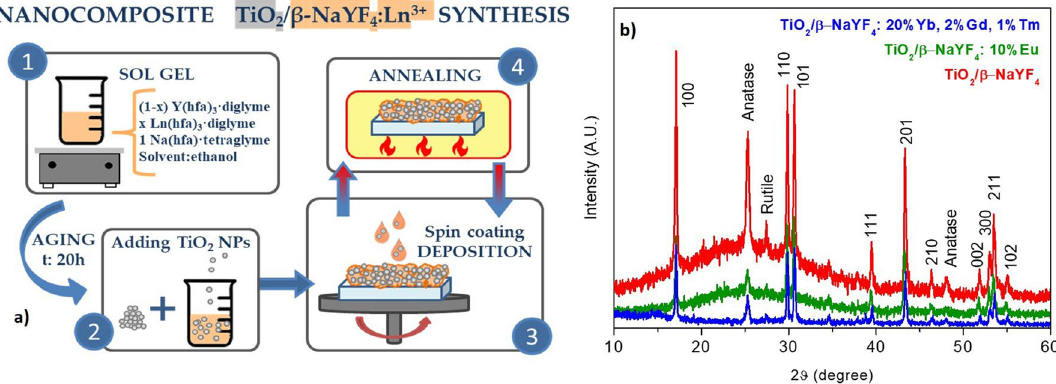
Figure 1. ( a ) Scheme of the composite synthesis from the sol–gel formation to the film deposition. ( b ) XRD patterns of undoped TiO 2 /β-NaYF 4 composite and doped with different amounts of doping ions Yb 3+ , Gd 3+ and Tm 3+ , and Eu 3+ [deposition temperature: 400 °C; substrate: glass for sample in red and green, and Si for sample in